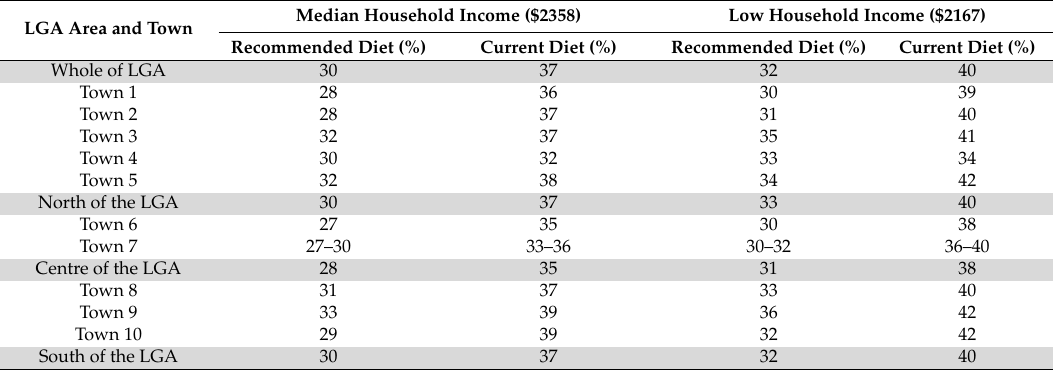
Table 4. Affordability (% household income) of the recommended diet and current diet across the Local Government Area (LGA) for the reference household by median and low income